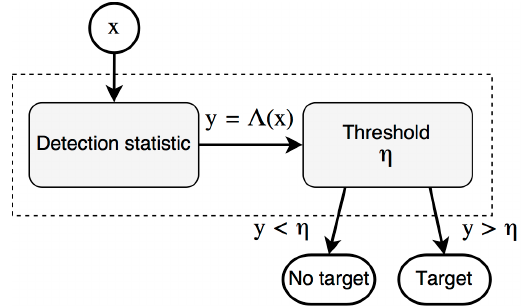
Figure 5. LR detector approach, according to [16]. A static method classifies a given spectrum as target or background, depending on a threshold.